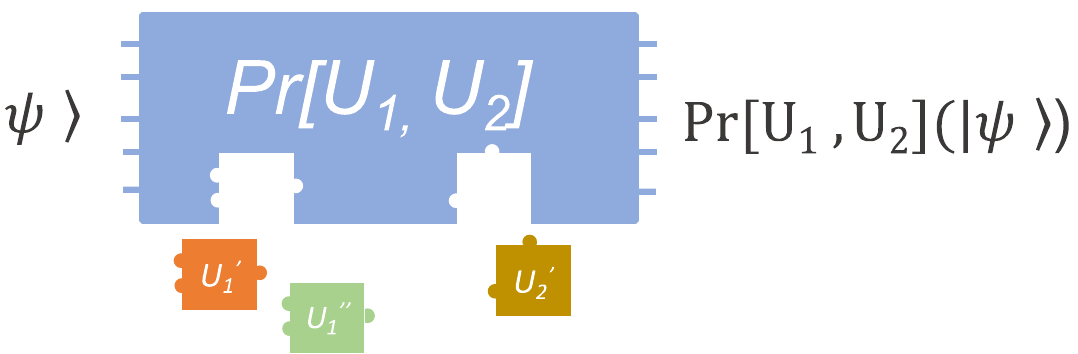
Figure 3. A modular approximation for quantum computing. Given a set of qubits at input, they are processed according to a given circuit, which is parametrized by many entry points where different U modules can be plugged into.